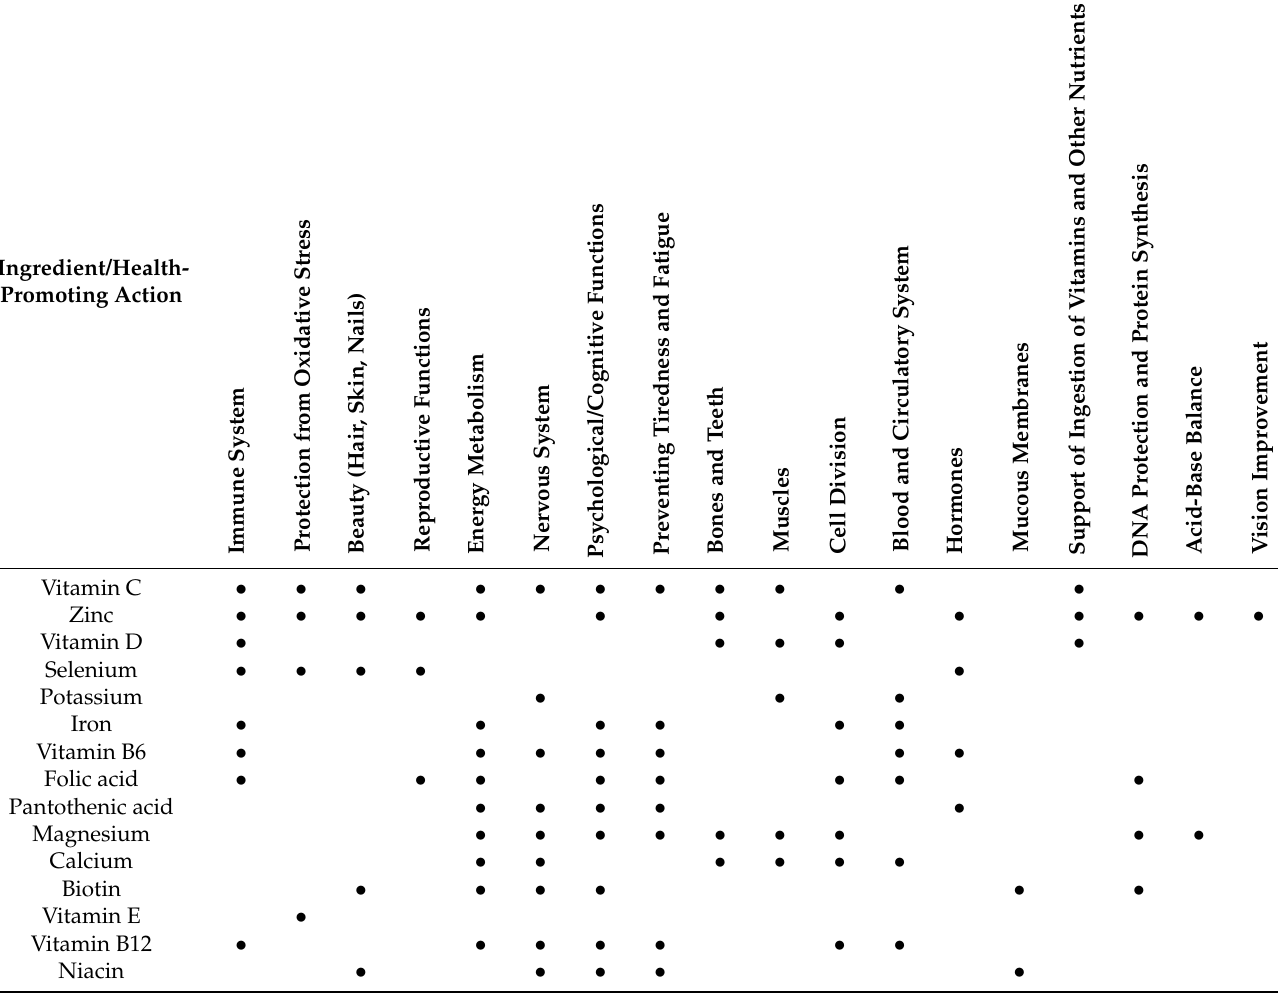
Table A4. List of health claims that can be attributed to the individual